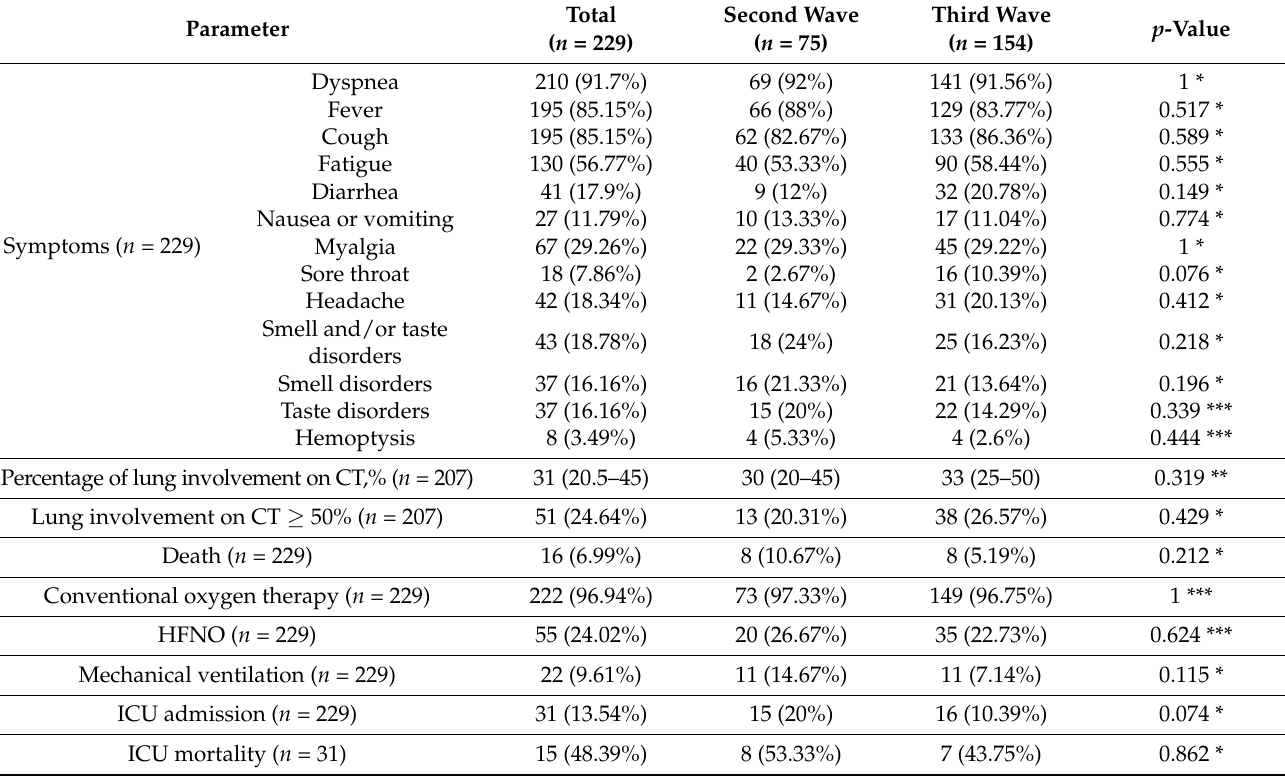
Table 2. Comparison of clinical patients’ characteristics between the second and the third